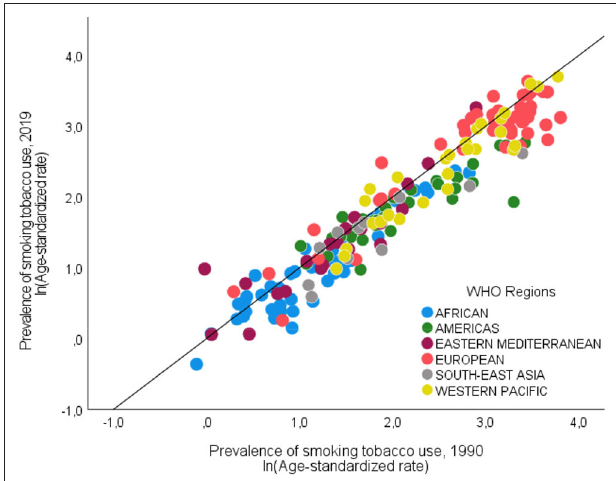
FIGURE 2 | Prevalence of smoking tobacco use among women (by WHO’s regions, 1990 vs. 2019). On both axes the natural log of the age stand. rate of smoking tobacco use (female, aged ≥ 15 years).